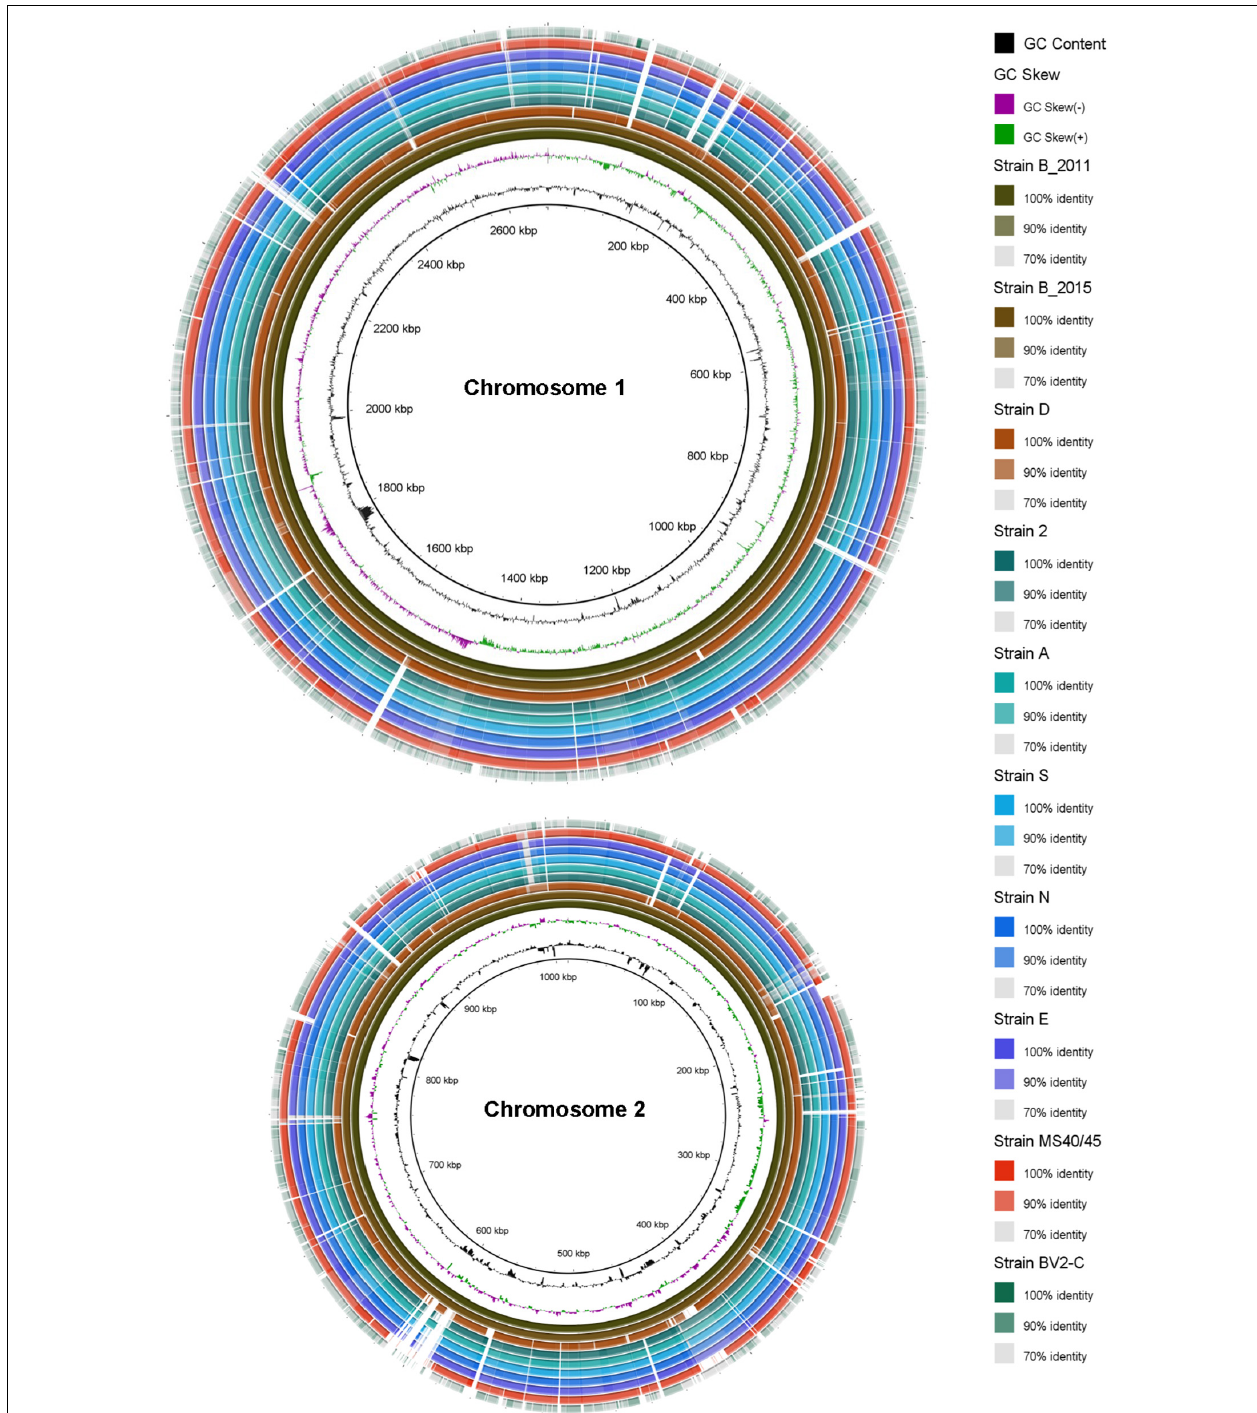
FIGURE 1 | Circular comparative representation of the Chloracidobacterium spp. whole genomes based upon BLAST-based homology of nucleotide sequences. The complete genome of each strain comprises two chromosomes with different lengths ( ∼ 2.6 Mbp and ∼ 1.0 Mbp, respectively; see Table 1 ). The genome of strain B (2011) was used as the reference genome. Circles (from inside to outside) 1 and 2 depict GC content (black line) and GC skew (magenta and green lines); circle 3: strain B T (2011) genome; circle 4: strain B T (2015) genome mapped against the strain B T (2011) genome; circle 5: strain D genome mapped against the strain B T (2011) genome; circle 6: strain 2 genome mapped against the strain B (2011) genome; circle 7: strain A genome mapped against the strain B (2011) genome; circle 8: strain S genome mapped against the strain B (2011) genome; circle 9: strain N genome mapped against the strain B (2011) genome; circle 10: strain E genome mapped against the strain B (2011) genome; circle 11: strain MS40/45 genome mapped against the strain B (2011) genome; circle 12: strain BV2-C genome mapped against the strain B (2011) genome. Legends on right hand side showing color gradient for% similarity. BRIG 0.95 was used to build the circular representation (Alikhan et al., 2011). Mapping studies were done using BLASTn with an e-value cut-off of 1 × e − 5 . Frontiers in Microbiology |